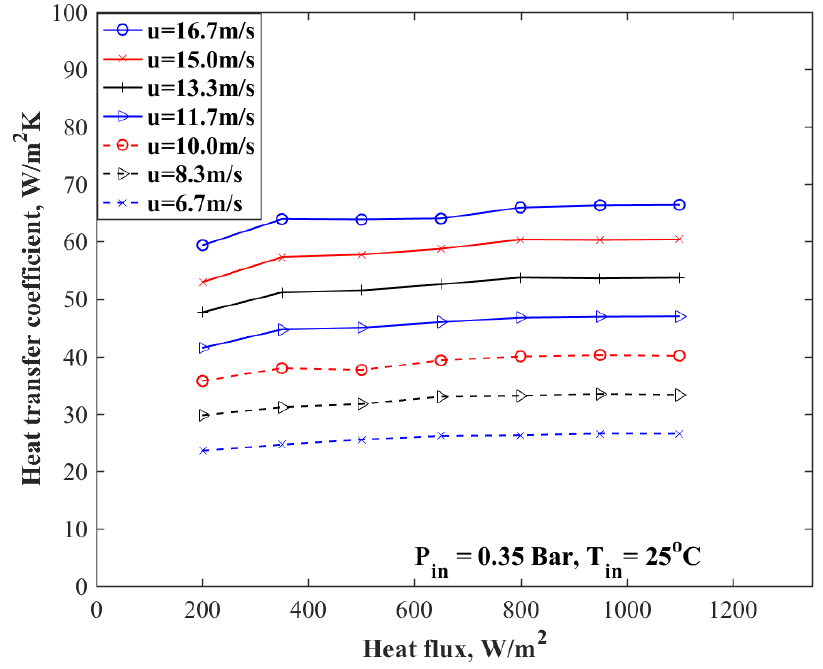
Figure 8. The effect of heater throughput (HFV) on the convective HTC at T= 25 °C.